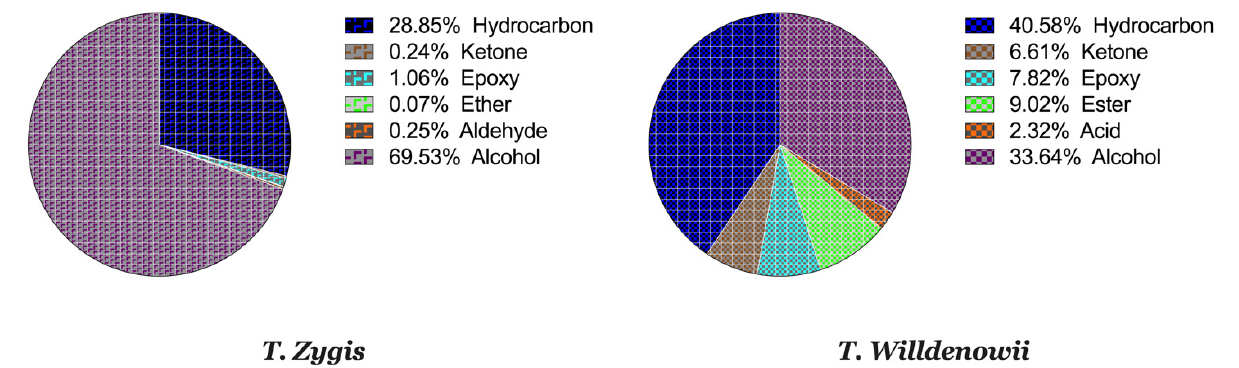
Figure 2. Percentage of chemical families in the thymes EO.